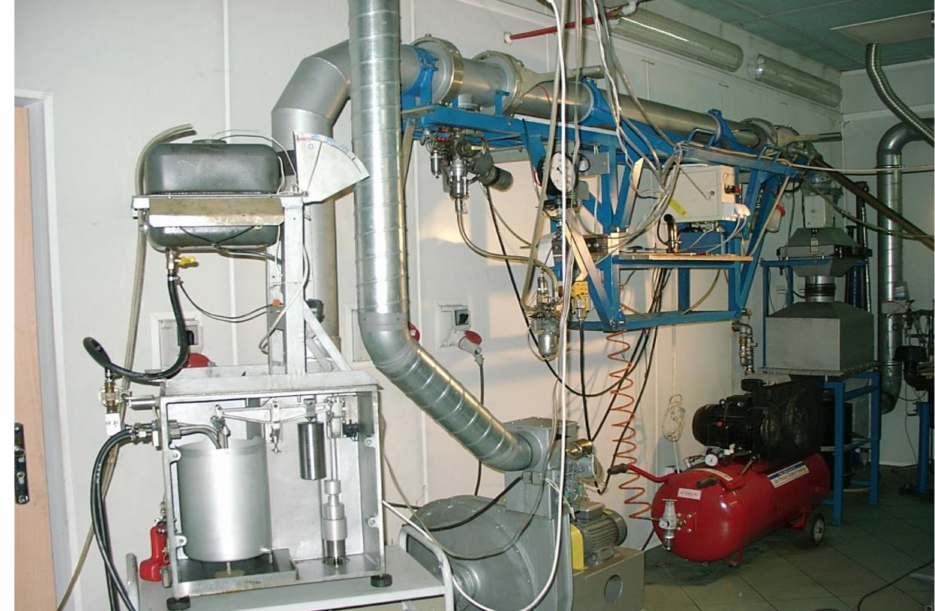
Figure 5. Exhaust DT for the determination of PM